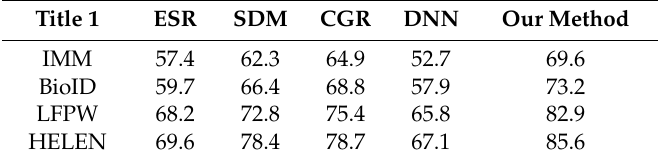
Figure 19. Some alignment results on the samples from the different databases. ( a ) IMM; ( b ) BioID; ( c ) LFPW; ( d ) HELEN. Table 1. The efficiency comparison of different methods on different databases (ms).